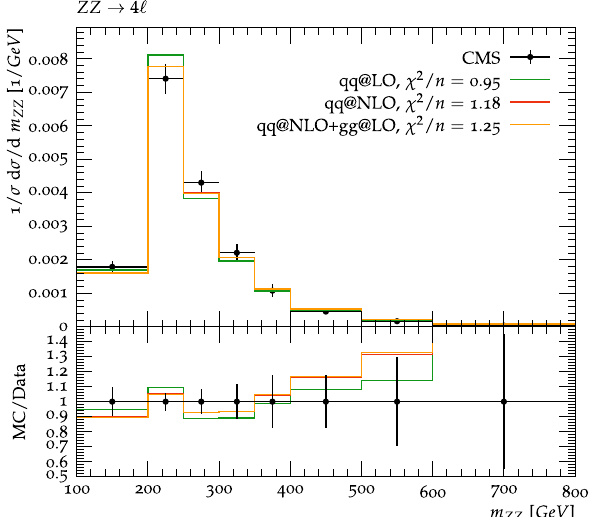
Fig. 11 Normalized d σ/ dm ZZ distribution in the fiducial phase space from the CMS measurement based on L = 137 fb − 1